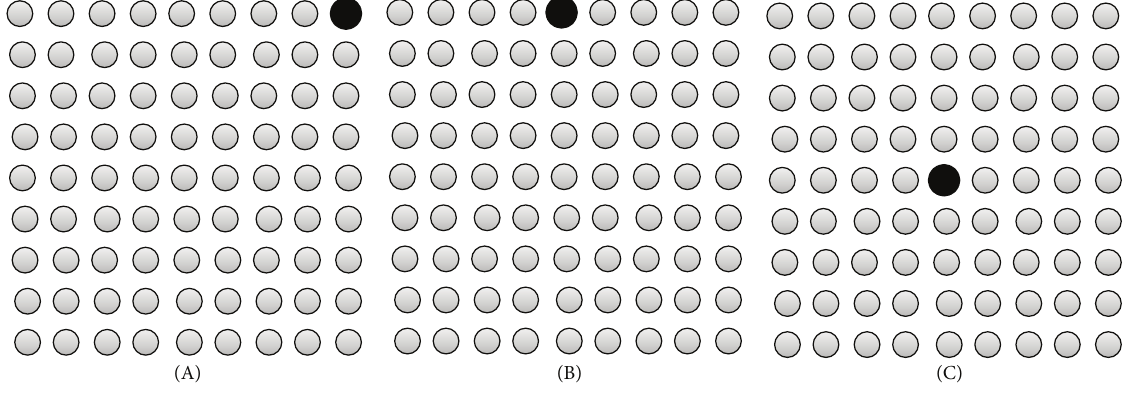
Figure 4: Sink node (in black) placement for topologies (A), (B), and (C).